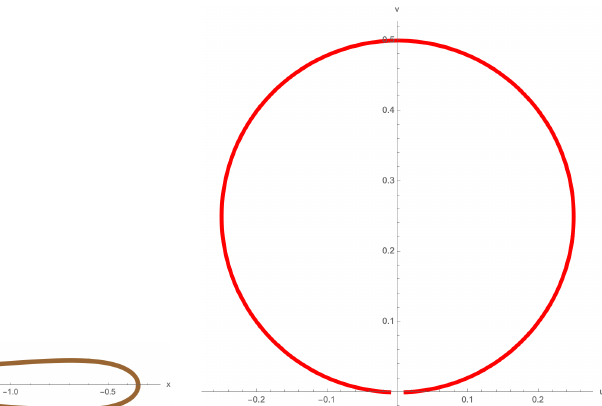
√ 3, θ = π , c 0 = 0, c 1 = 0, c 2 = 3